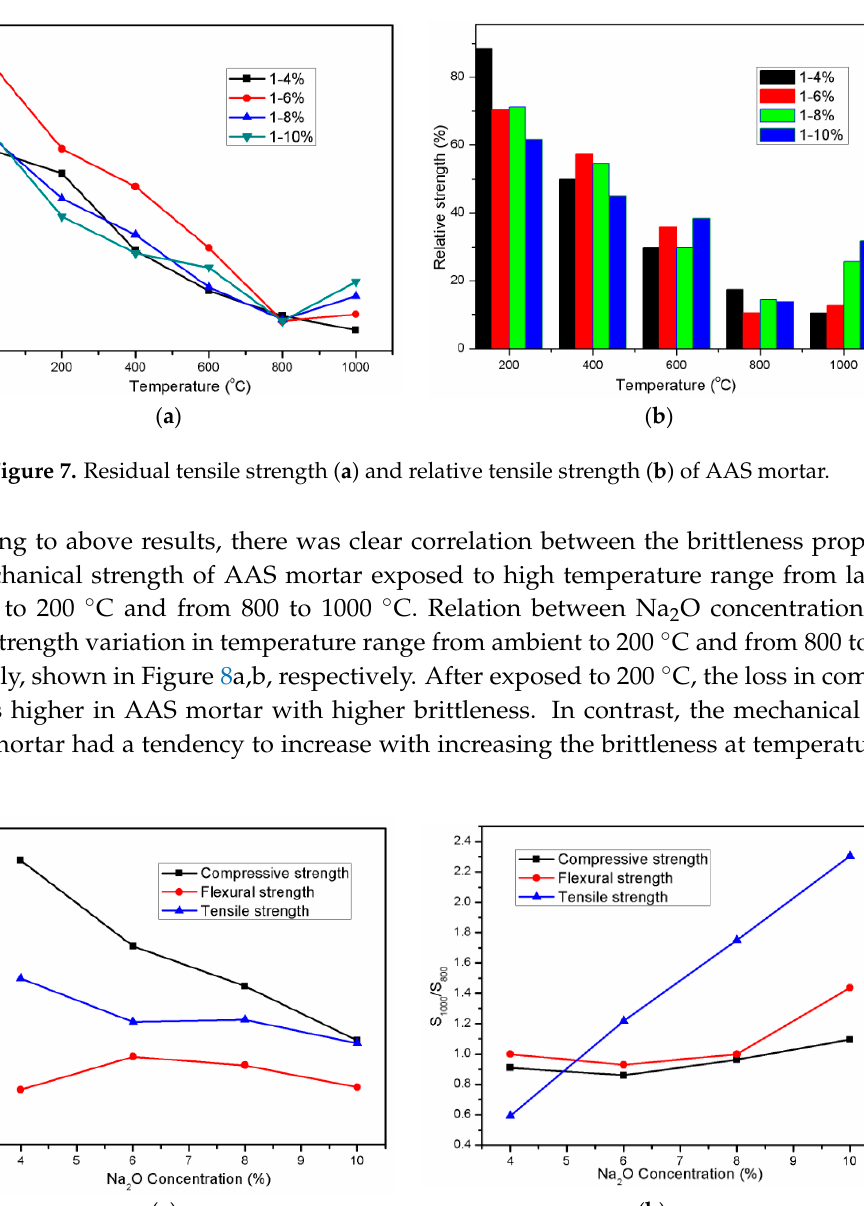
Figure 8. Relation between Na 2 O concentration and the strength of AAS mortar after exposure to high temperature range: ( a ) From laboratory temperature to 200 ° C ; and, ( b ) From 800 to 1000 ° C .